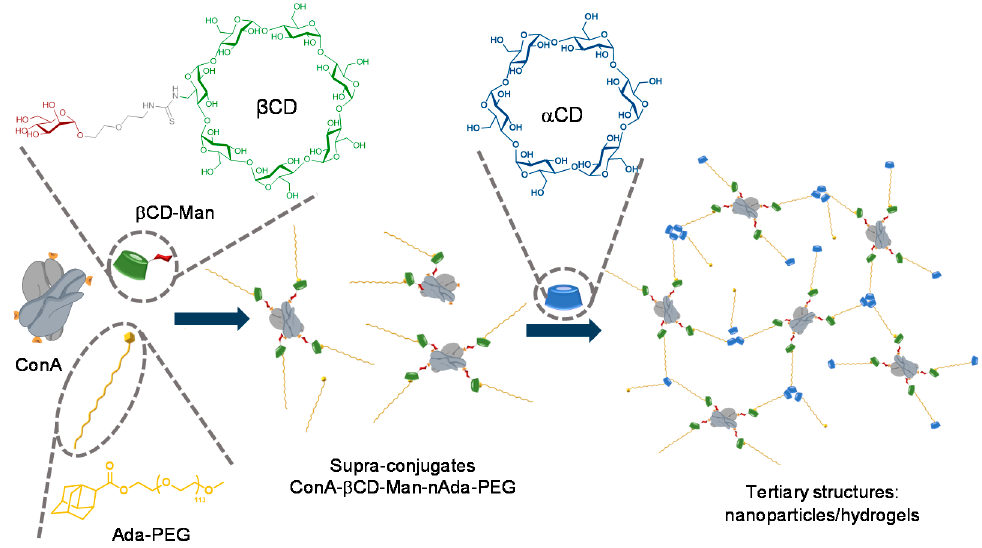
Figure 12. Molecular structures and schematic illustrations of the mannosylated β CD derivative β CD-Man, the adamantane-equipped poly(ethylene glycol) derivative Ada-PEG, concanavalin A (ConA) and α CD, and of their combination to obtain supramolecular nanoparticles and hydrogels, as reported by Chen and coworkers [82]. CD, cyclodextrin; Man. Mannose; Ada-PEG, adamantane-equipped poly(ethylene glycol), ConA, concanavalin A.